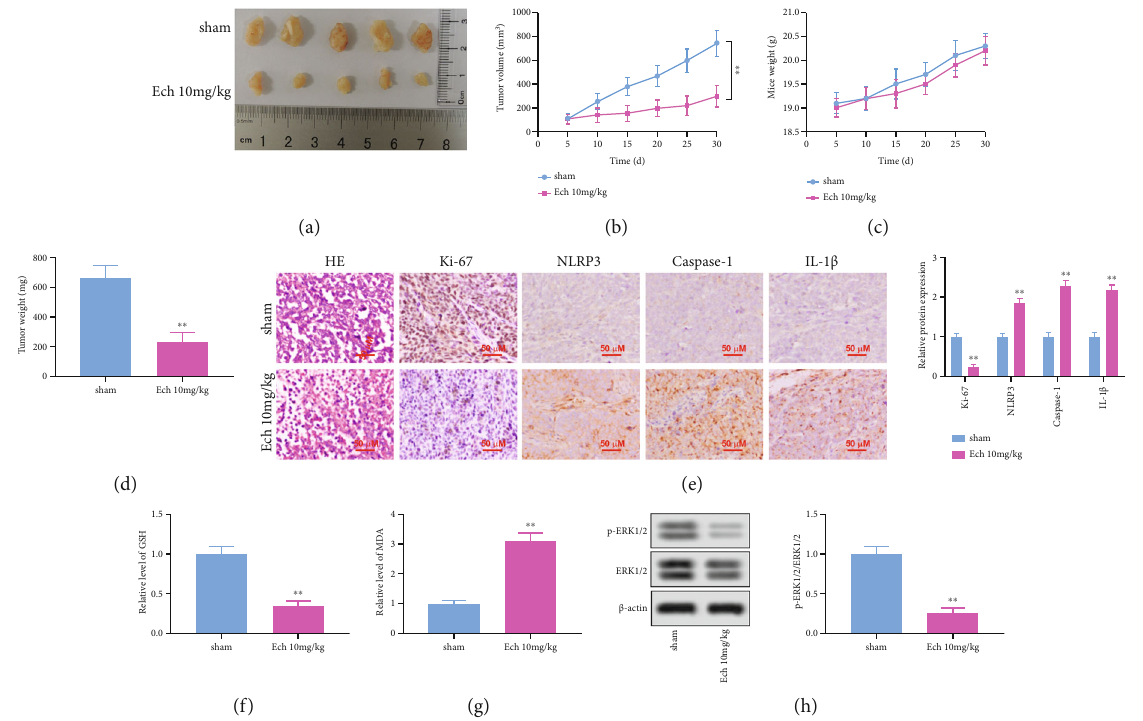
Figure 5: Ech frustrated the growth of NSCLC cells in vivo . (a) Representative tumorigenic images. (b) Statistical chart of tumor volume. (c) Average weight of mice (calculated from group weight divided by number of mice weighted) taken over a course of 30 days. D Statistical chart of tumor weights. E Results of H&E staining and immunohistochemistry of tumor tissues (Bar =50 μ m). Determination of GSH (f) and MDA (g) levels in the tumor tissues. (h) Total lysates were harvested for the assay of ERK1/2 and phosphorylated ERK1/2 protein levels using western blot analysis. Data were represented as mean ± SD . ∗∗ P < 0 : 01